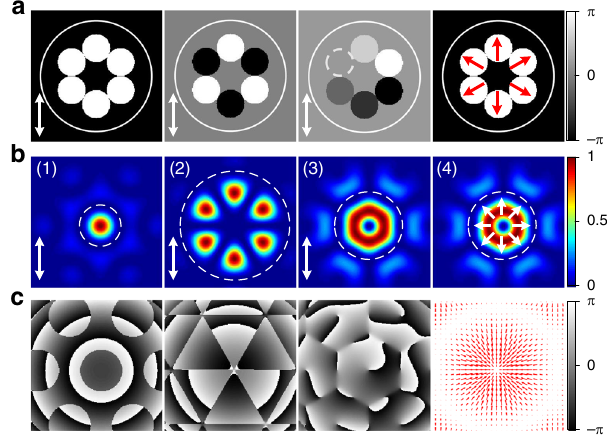
Fig. 1 Calculation of coherently combined modes from a 6-core MCF. a Examples of phase and polarization distributions of the MCF beamlets for the generation of various structured light beams. b , c Calculated far- fi eld ( b ) intensity, ( c ) phase or polarization state distributions of the synthesized modes (white and red arrows show the polarization